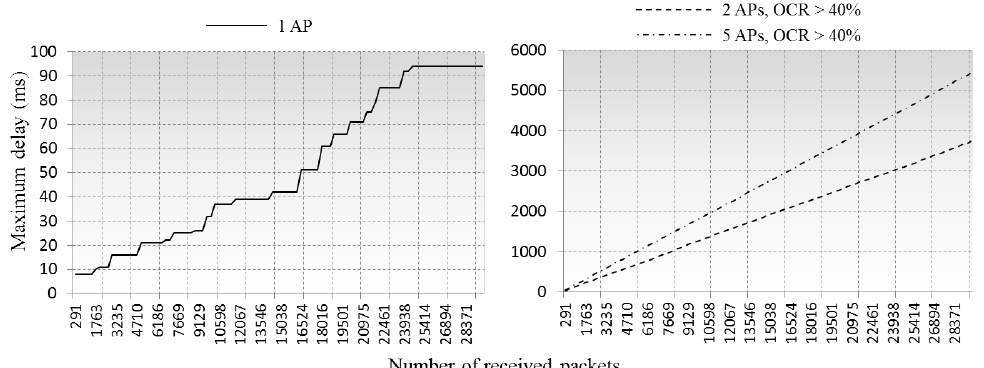
Figure 8. Comparison of maximum queuing delay of arrived